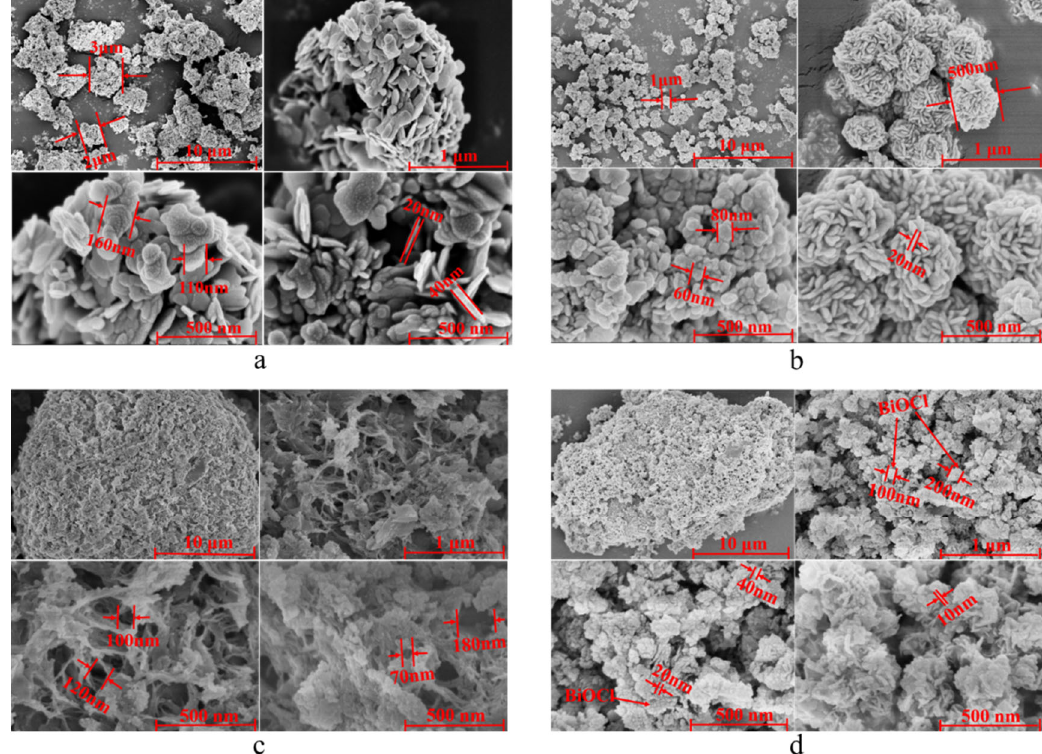
Figure 2. SEM images of pure BiOCl (( a ) B25, ( b ) B0), clinoptilolite support (( c ) NC-Na-3.0) and 40B0/CN ( d ).